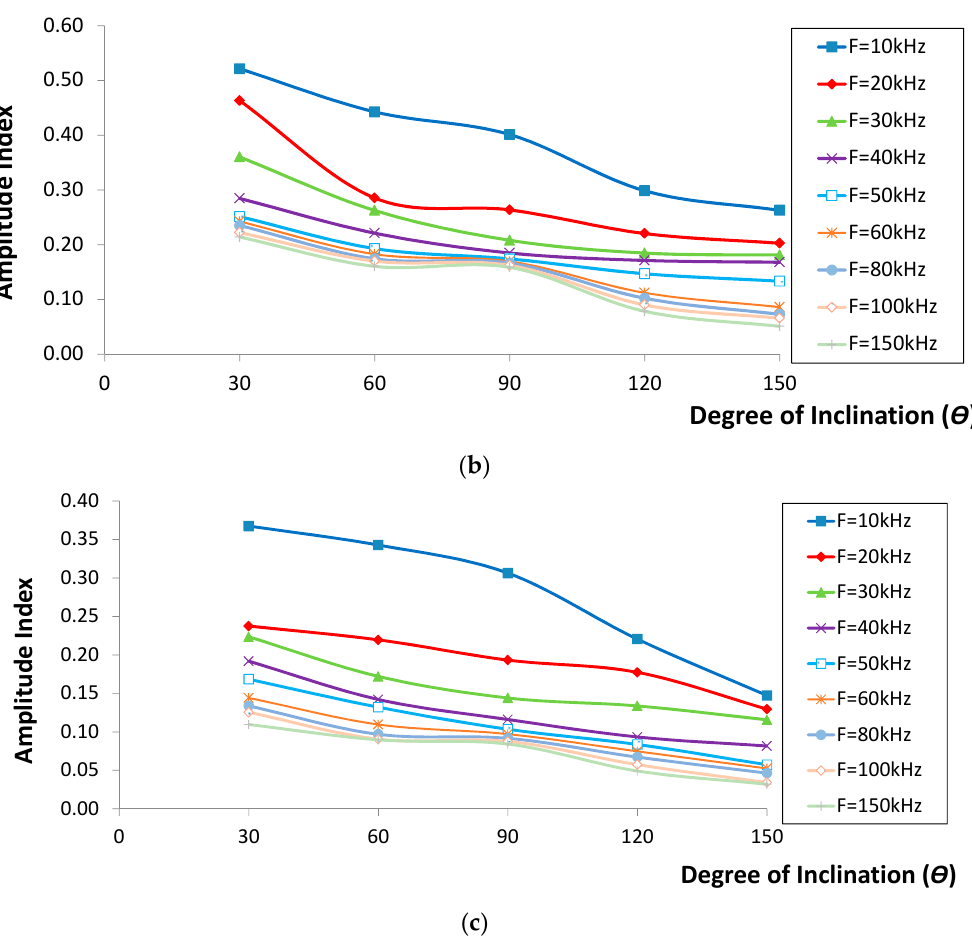
Figure 8. Amplitude index versus different degree of inclination for crack depth of ( a ) 30 mm; ( b ) 90 mm and ( c ) 150 mm.